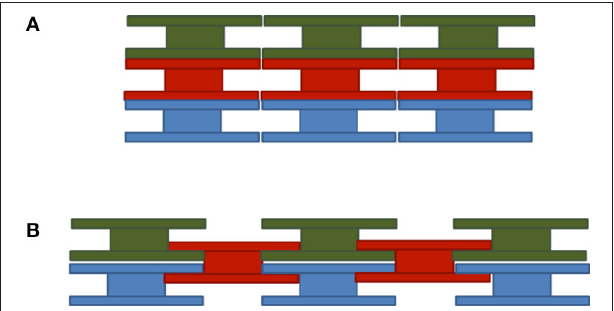
FIGURE 3 | Schematic representation of (A) stacked and (B) interlocked liths coccosphere models. Three dimensional electron microscopy images indicate that the interlocked pattern is the one closest to reality (Hoffmann et al.,